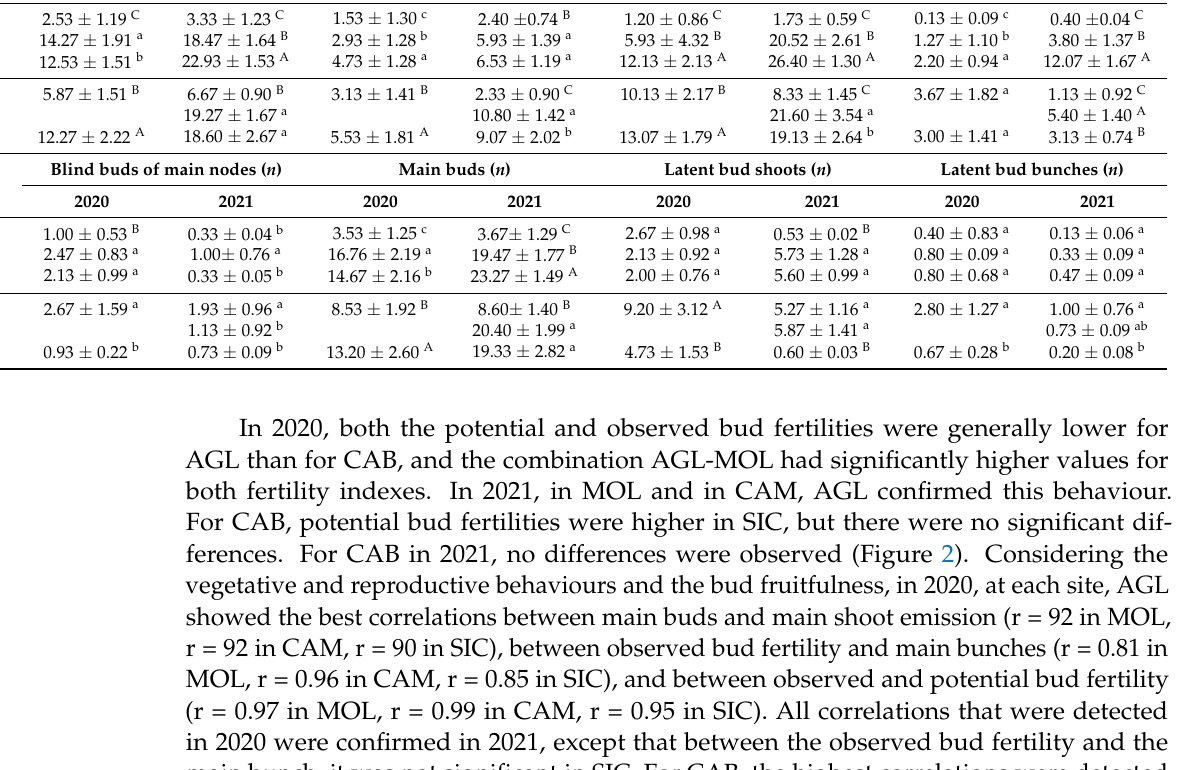
Table 3. Vegetative and reproductive behaviours in each of two cultivars, Aglianico (AGL) and Cabernet Sauvignon (CAB), grown at three different sites, Molise (MOL), Campania (CAM), and Sicily (SIC). Measurements were made when all inflorescences were fully developed (Biologische Bundesanstalt, Bundessortenamt and CHemical industry: inflorescence 57). Mean values for each parameter, indicated by different letters, are significantly different (lowercase letter p ≤ 0.05, uppercase letter p ≤ 0.001, ± indicates one standard deviation), based on Tukey’s HSD test within years and cultivars. Bourillon and Crown Shoots ( n ) Main Bunches ( n ) Bourillon and Crown Inflorescences ( n